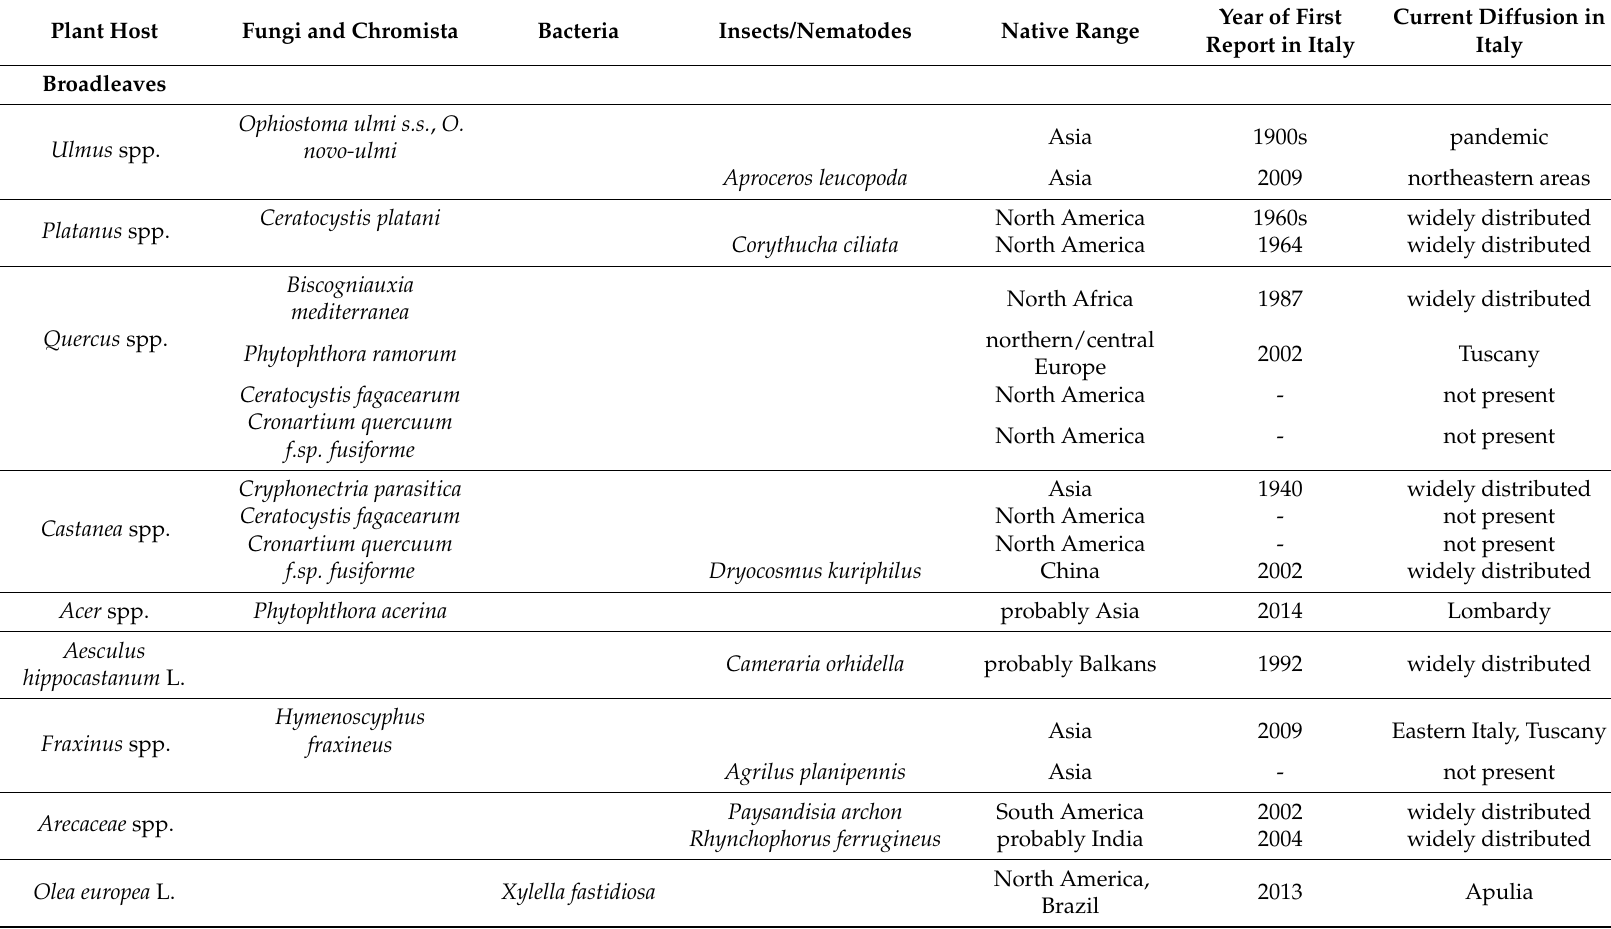
Table 1. Main introduced and impending diseases and insect pests that are harmful for plants in urban and peri-urban areas in Italy. Plant Host Fungi and